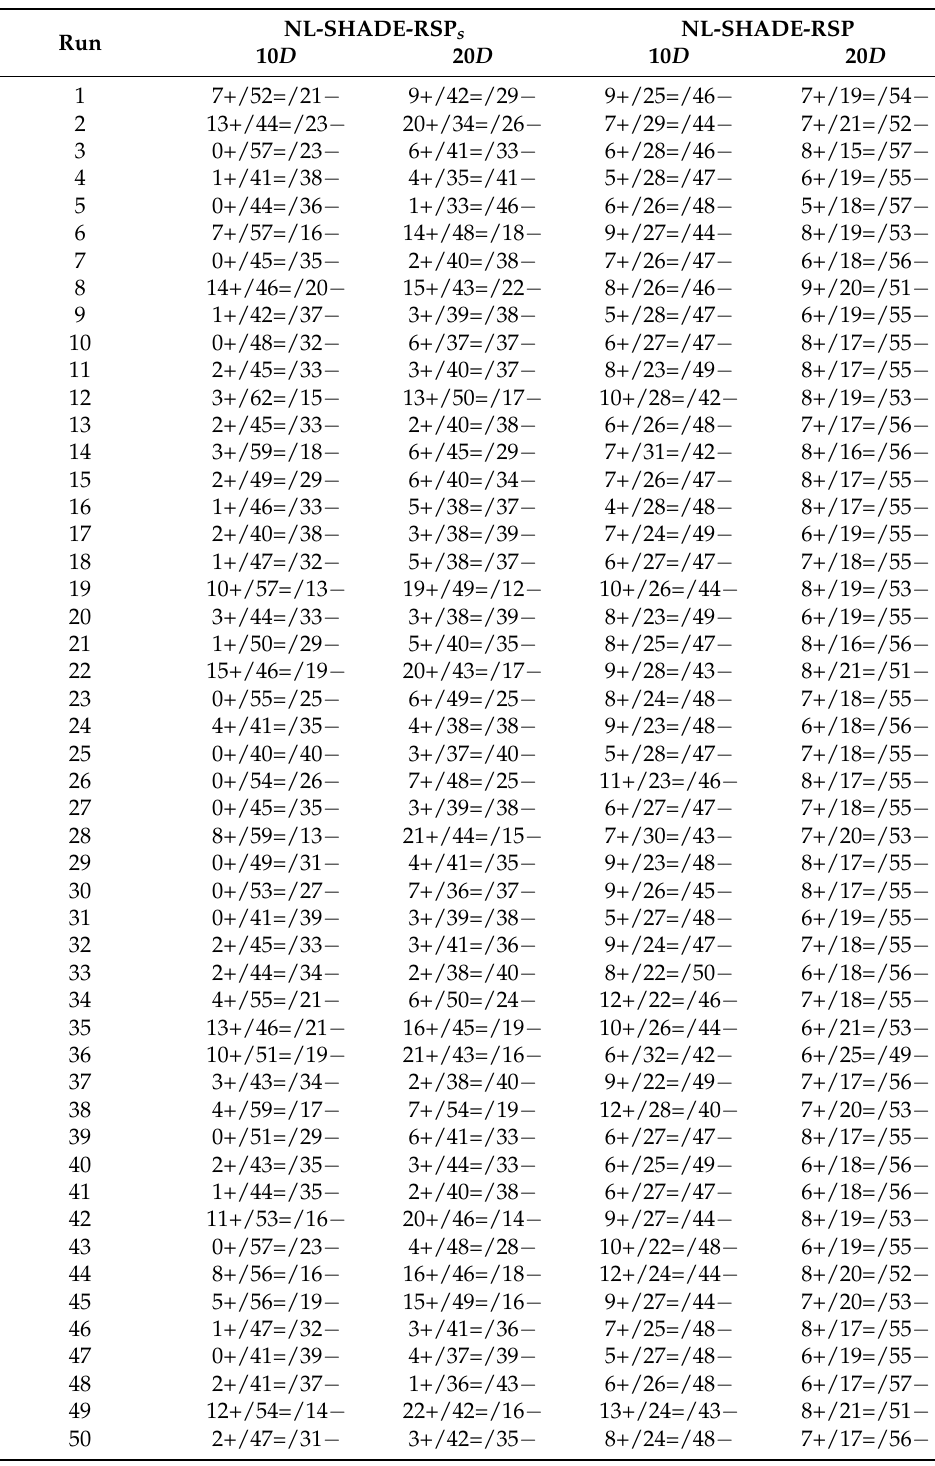
Table 3. Comparison of HA-NEAT-DBM heuristics on CEC 2021 benchmark functions, Mann–Whitney